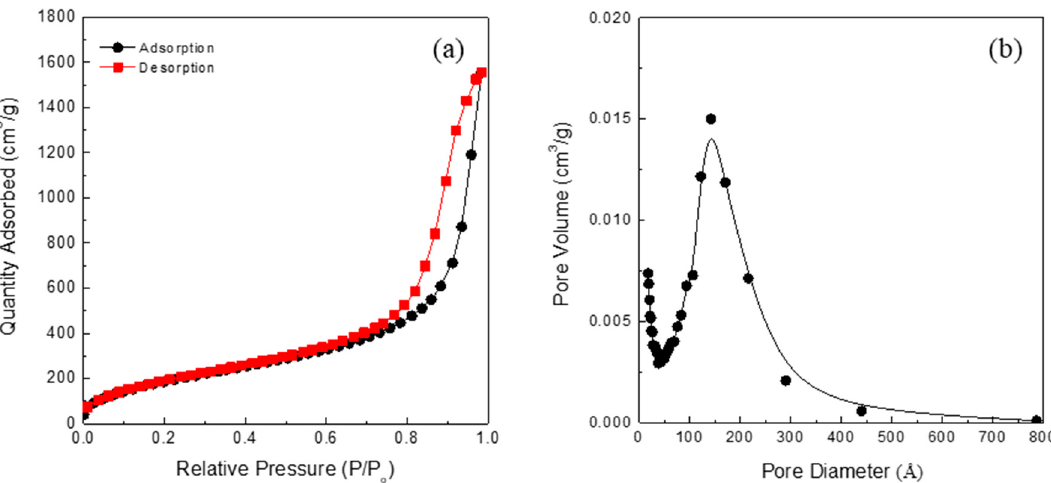
Figure 2. N 2 adsorption–desorption isotherm ( a ) and pore size distribution of the starting silica aerogel powder ( b ).